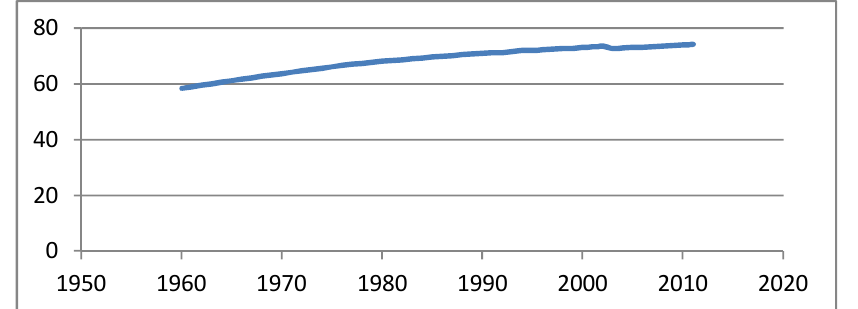
Figure 5: Life expectancy at birth, total (years)